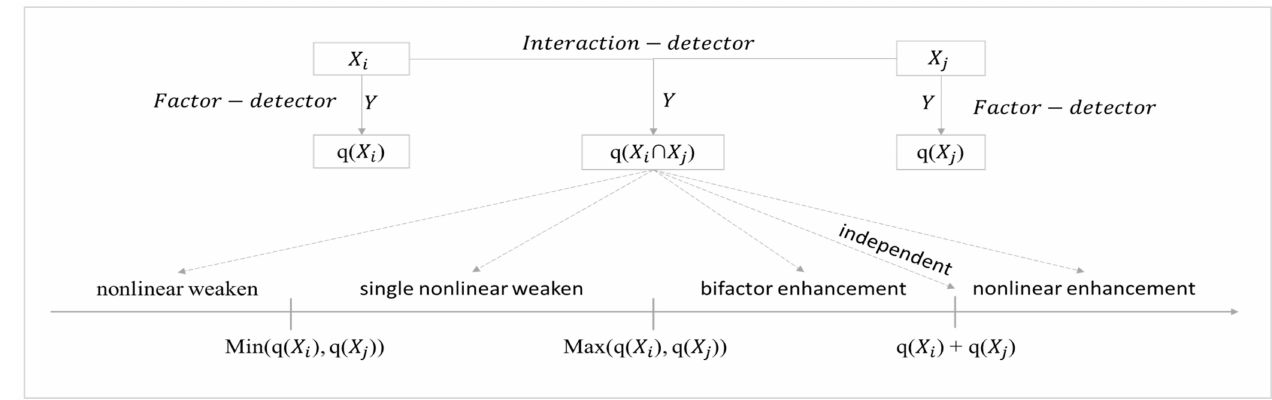
Figure 3. Analysis on the interaction between